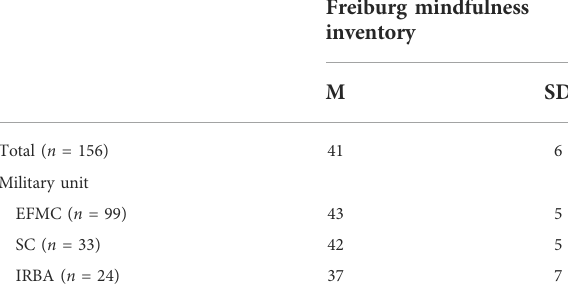
TABLE 3 Score of trait mindfulness, as assessed with the Freiburg Mindfulness Inventory, for the three military units from which the examples originated. These data pertain to the 156 subjects selected from the study (see Participants section).